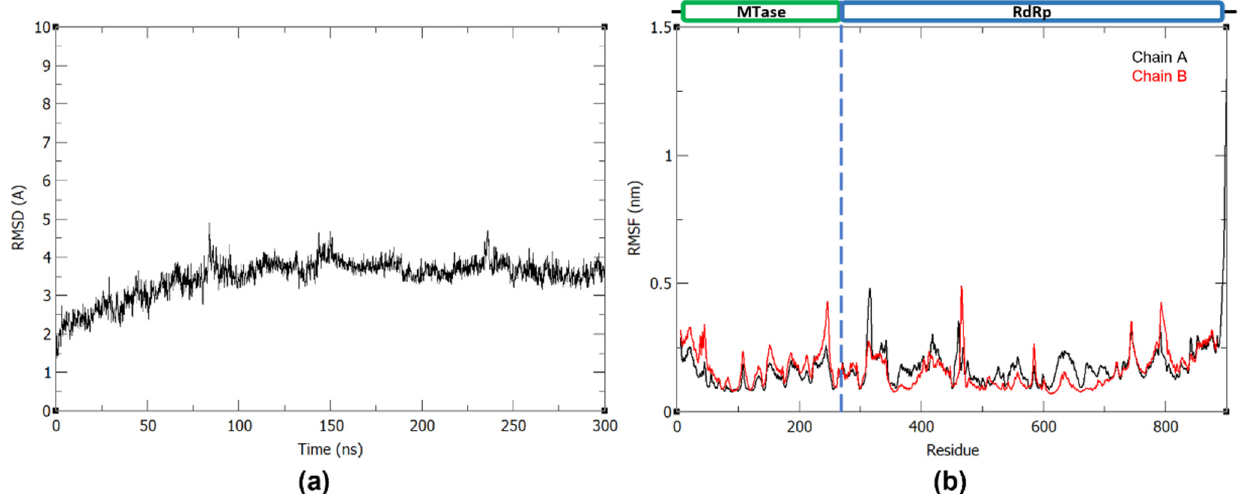
Figure 6. ( a ) Backbone RMSD plot of the R673A NS5 mutant and ( b ) RMSF plot of the R673A NS5 mutant chain A and B.